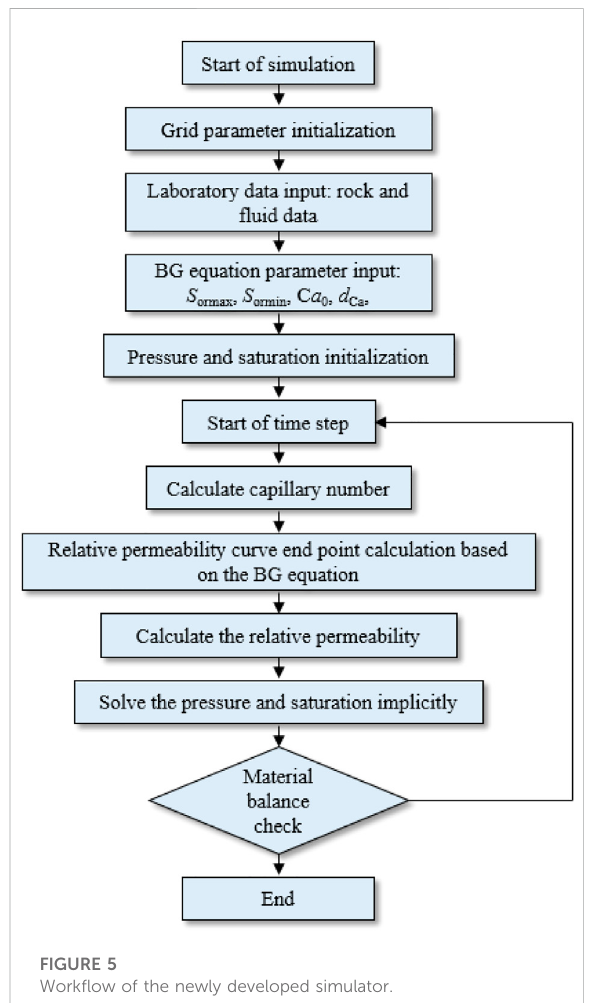
FIGURE 5 Work fl ow of the newly developed simulator.